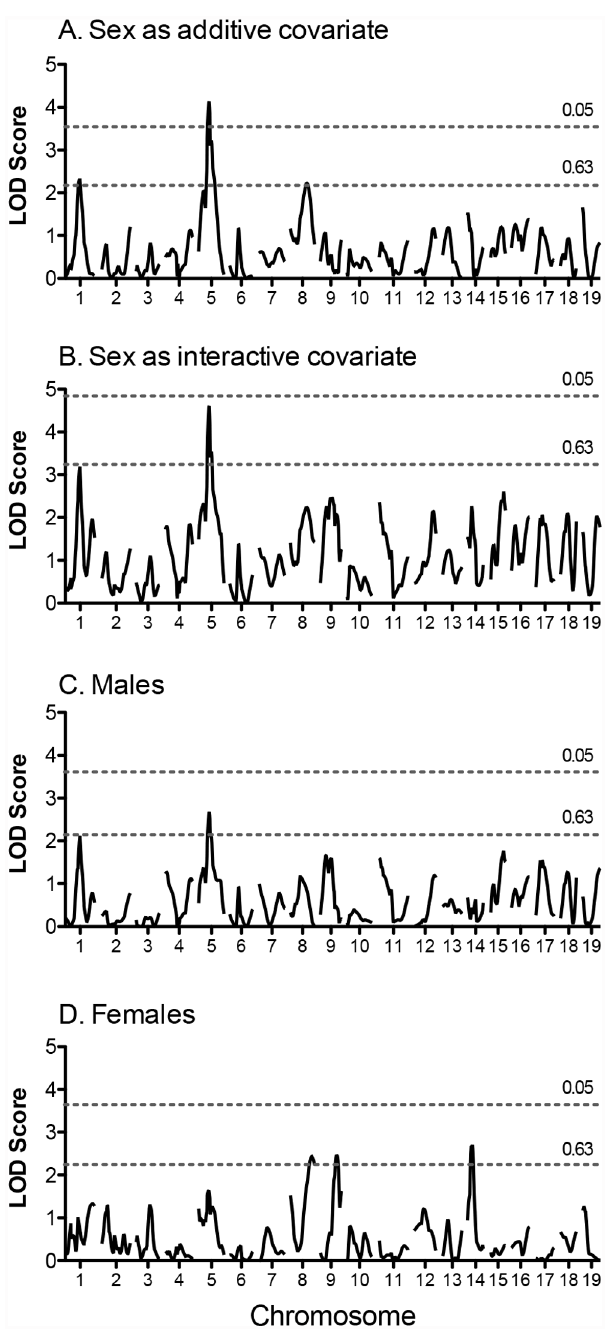
Fig 2. Genome-wide scan for post-training exercise time in (NZW x 129S1) F 2 mice. Scans were performed for the entire population with “ sex ” as an additive covariate (A) or interactive covariate (B), and in males (C) and females (D) separately. Horizontal lines represent significant (P = 0.05) and suggestive (P = 0.63) logarithm of odds (LOD) thresholds, respectively. LOD thresholds were determined by permutation testing using 1000